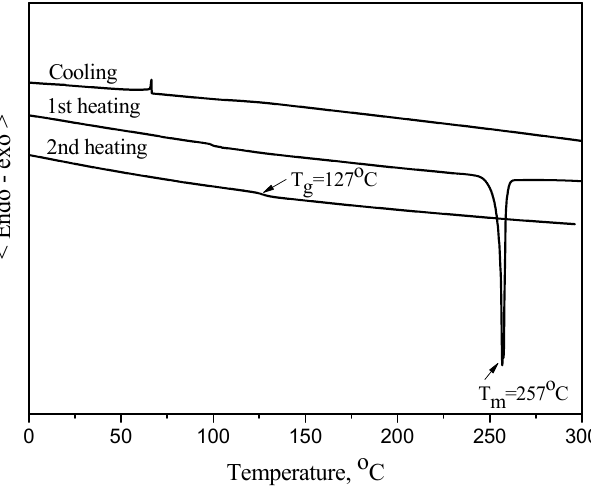
Figure 2. DSC curves of the material H1 . On the other hand, the compound H2 was obtained as fully amorphous material after its synthesis, as confirmed by the DSC. The thermo-grams of the compound H2 are shown in Figure 3. During the first and second heating scans, only the high glass transition temperature (T g ) of 139 ◦ C was detected for the compound. Crystallization or melting signals were not registered during these heating/cooling scans in the area from 0 ◦ C to 350 ◦ C.